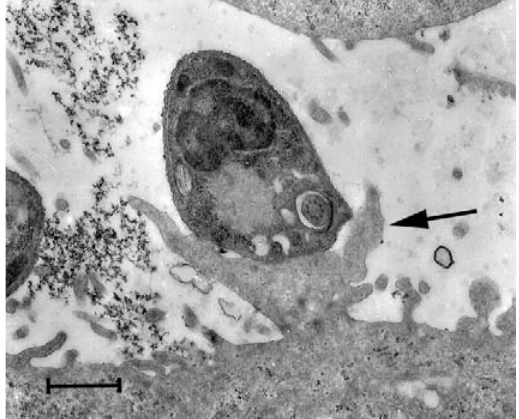
Fig. 3 – Formation of sleeve-like pseudopodia around trypo- mastigotes invading HeLa cells. Scanning electron microscopy showing the membrane expansion (arrow) around the invading trypomastigote (Schenkman and Mortara 1992). Bar: 2 µ m. and Mortara 1992). Later on, other